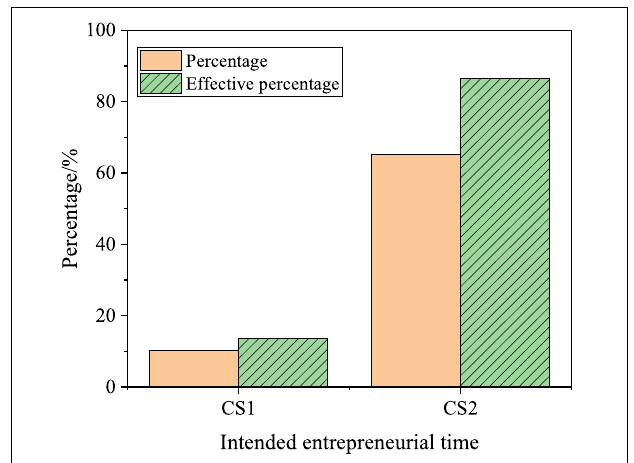
FIGURE 13 | Statistics of the time when college students intend to start a business.